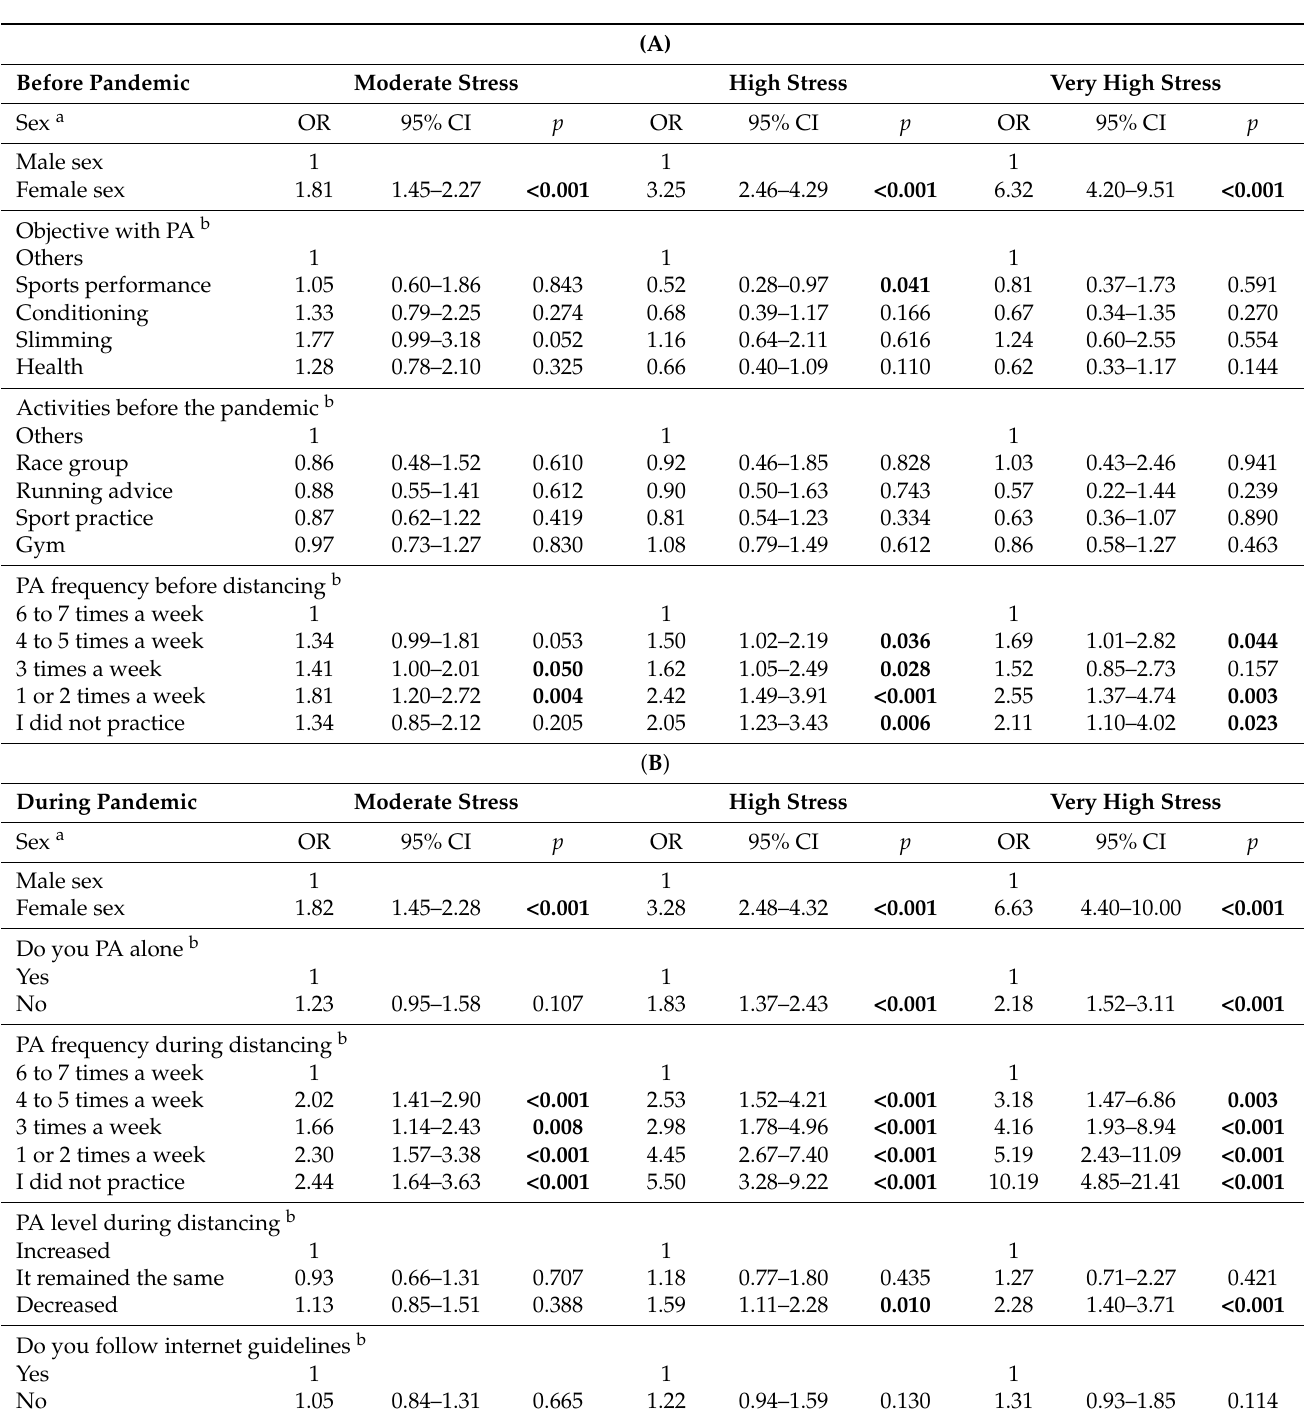
Table 3. ( A ) Adjusted association of variables included in the study according to psychological distress (anxiety and depression) before the pandemic (N = 2000). ( B ) Adjusted association of variables included in the study according to psychological distress (anxiety and depression) during the pandemic (N =